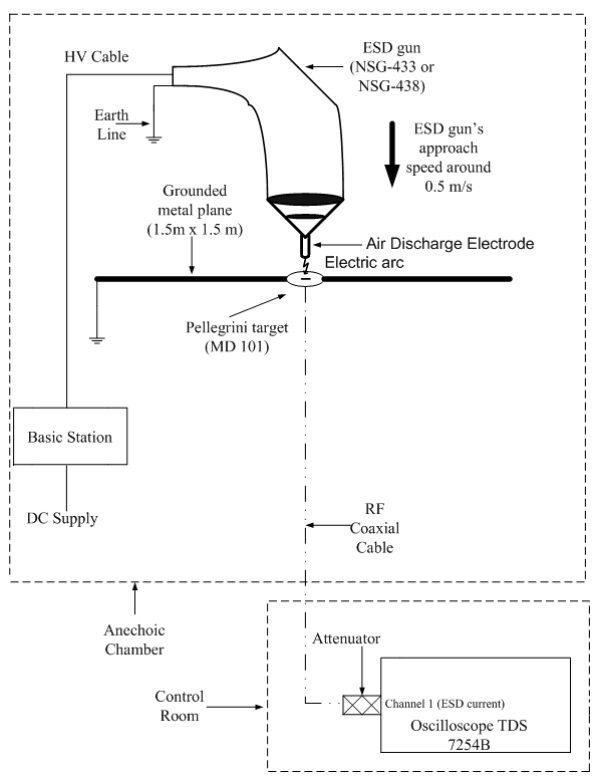
Figure 2. Test set-up during air